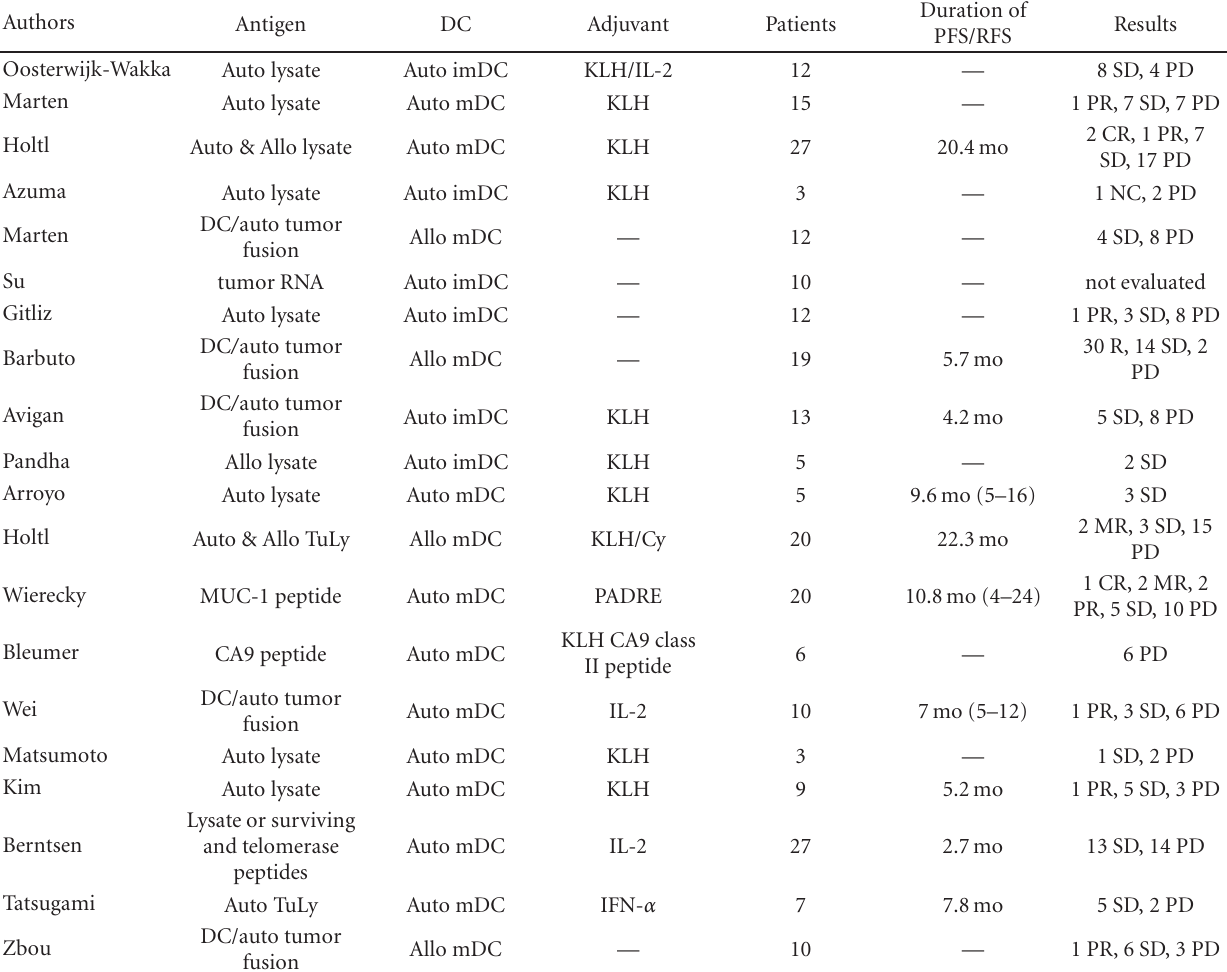
Table 3: DC-based